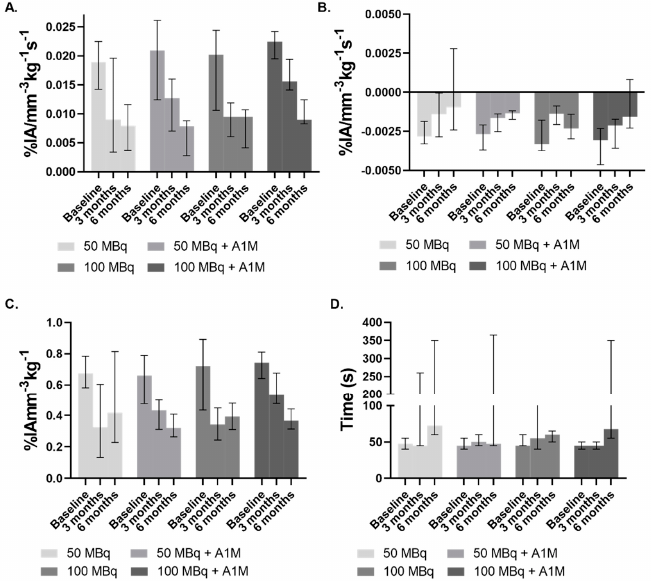
At six months, the SIU and peak values had deteriorated for all groups and were in a similar range. To evaluate this further, we imaged mice, administered with only vehicle, with [ 99m Tc]Tc-MAG3 SPECT/CT (n = 6), which showed that the SIU (median, 9.2 × 10 − 3 % IA mm − 3 kg − 1 s − 1 ; range, 1.3 × 10 − 2 –8.0 × 10 − 3 % IA mm − 3 kg − 1 s − 1 ) was similar to the other groups (Figure 3). This was also true for peak values (median, 0.36% IA mm − 3 kg − 1 ; range, 0.48–0.32% IA mm − 3 kg − 1 ). However, with regards to excretion, this group performed bet- Figure 2. Average kidney time activity curves (TACs), with standard deviation, following [ 99m Tc]Tc-MAG3 imaging at baseline (red), three (yellow) and six (blue) months post treatment with ( A ) 50 MBq of [ 177 Lu]Lu-PSMA-617 (Baseline, n = 6; three months, n = 5; six months, n = 4), ( B ) 50 MBq of [ 177 Lu]Lu-PSMA-617 with rA1M (Baseline, n = 6; three months, n = 4; six months, n = 4), ( C ) 100 MBq of [ 177 Lu]Lu-PSMA-617 (Baseline, n = 6; three months, n = 7; six months, n = 6), and ( D ) 100 MBq of [ 177 Lu]Lu-PSMA-617 with rA1M (Baseline, n = 6; three months, n = 4; six months, n = 4).